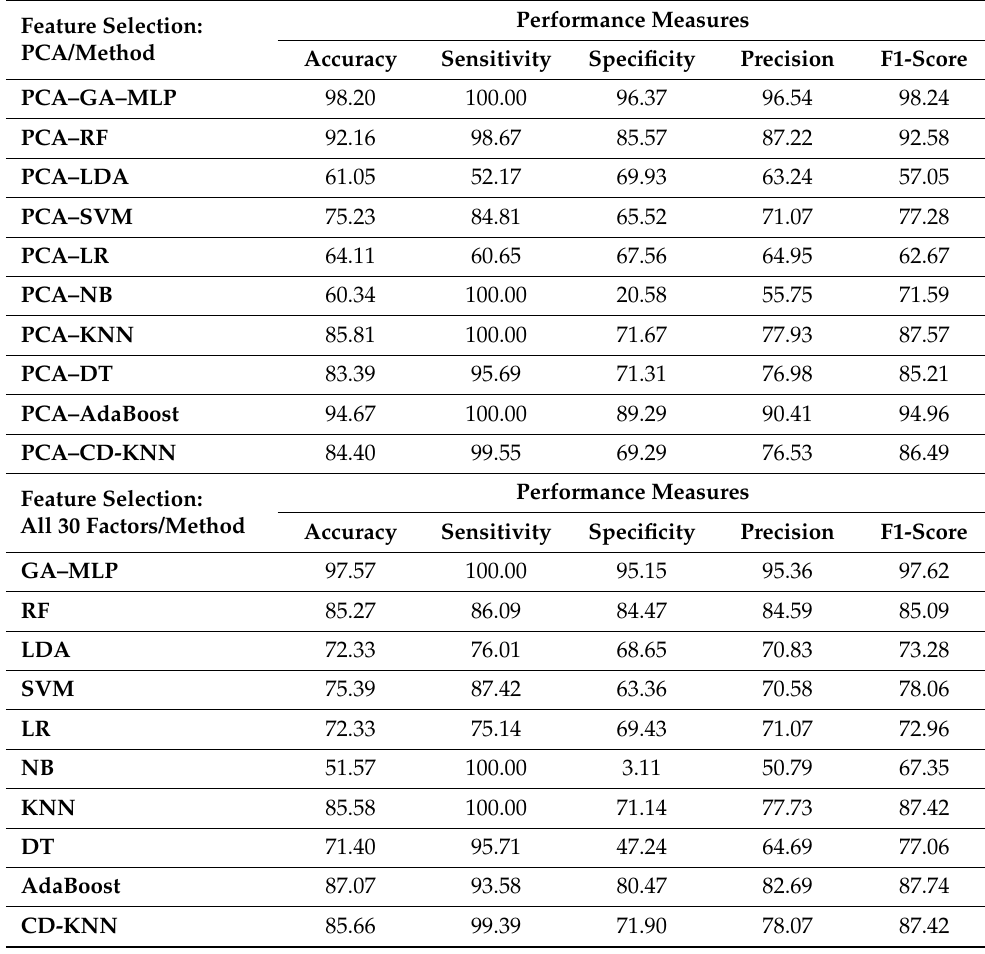
Table 5. Comparison of the proposed method using four feature selection methods with nine other classification algorithms in diagnosing